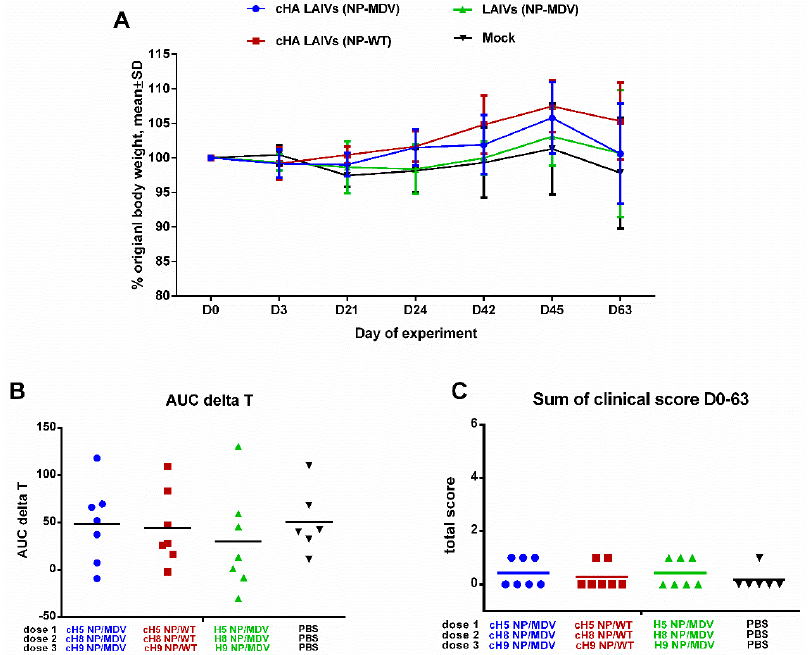
Figure 3. Safety of sequential immunization of ferrets. ( A ) Percentage body weight change. ( B ) Area under the curve of delta T relative to baseline temperature for each ferret over the immunization phase. ( C ) Scores for clinical signs of influenza infection in ferrets throughout the immunization period. No significant differences were observed for any of the parameters.